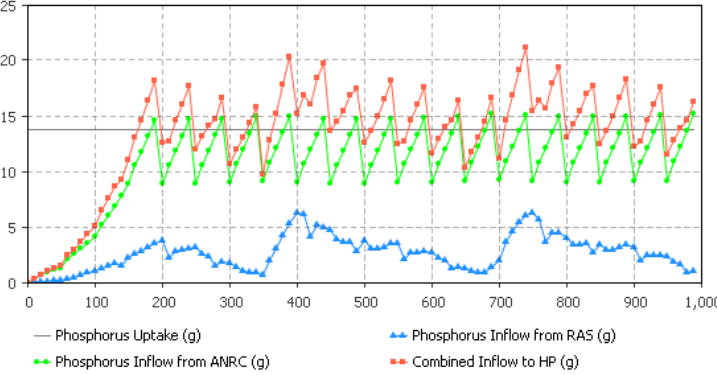
Figure 15. Dependent on the evapotranspiration rate (Figure 14), different nitrate flows from RAS to the hydroponic component can be observed. The RAS nitrate balance in mg ∙ L − 1 ( y ‐ axis) for the first 1000 days ( x ‐ axis) can be seen using exclusively natural illumination and a cultivation area of 600 m 2 .